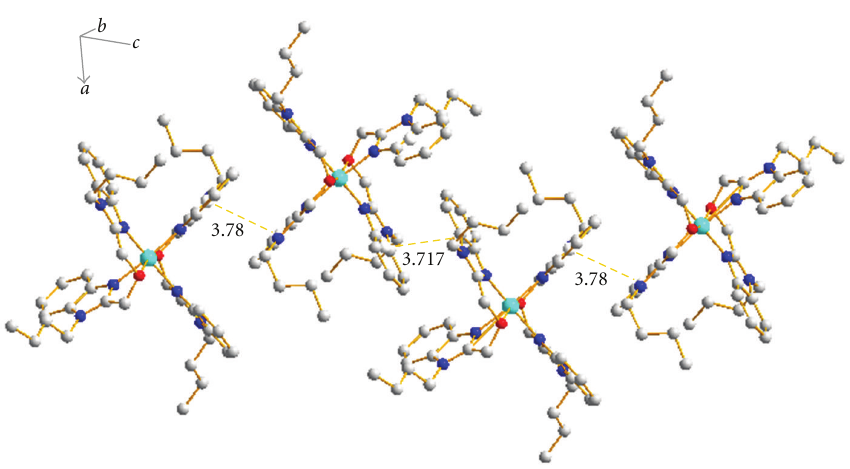
Figure 3: The structure of complex linked via π - π stacking